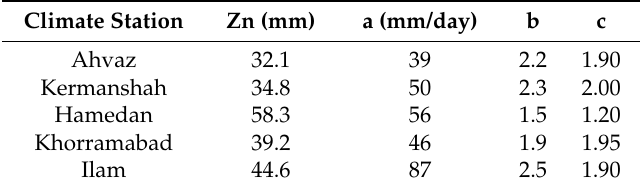
Table 3. Optimized parameter values of the SM2RAIN-Equations (1)–(3) for the 5 KRB climate stations.